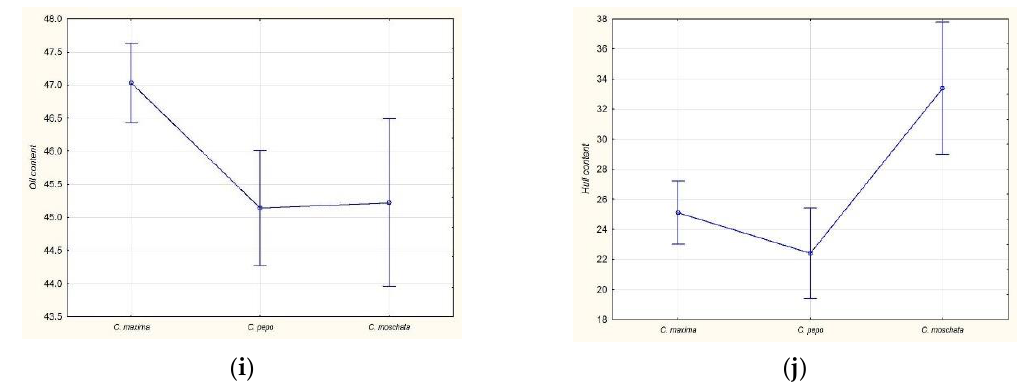
Figure 1. ANOVA diagrams for parameters of the studied seeds of Cucurbita species from the VIR collection: content of ( a ) palmitic, ( b ) stearic, ( c ) oleic, ( d ) linoleic, ( e ) linolenic acids; ( f ) total SFA (saturated fatty acids); ( g ) total USFA (unsaturated fatty acids); ( h ) FAI (fatty acids index) in seed oil; ( i ) seed oil content; and ( j ) hull content .